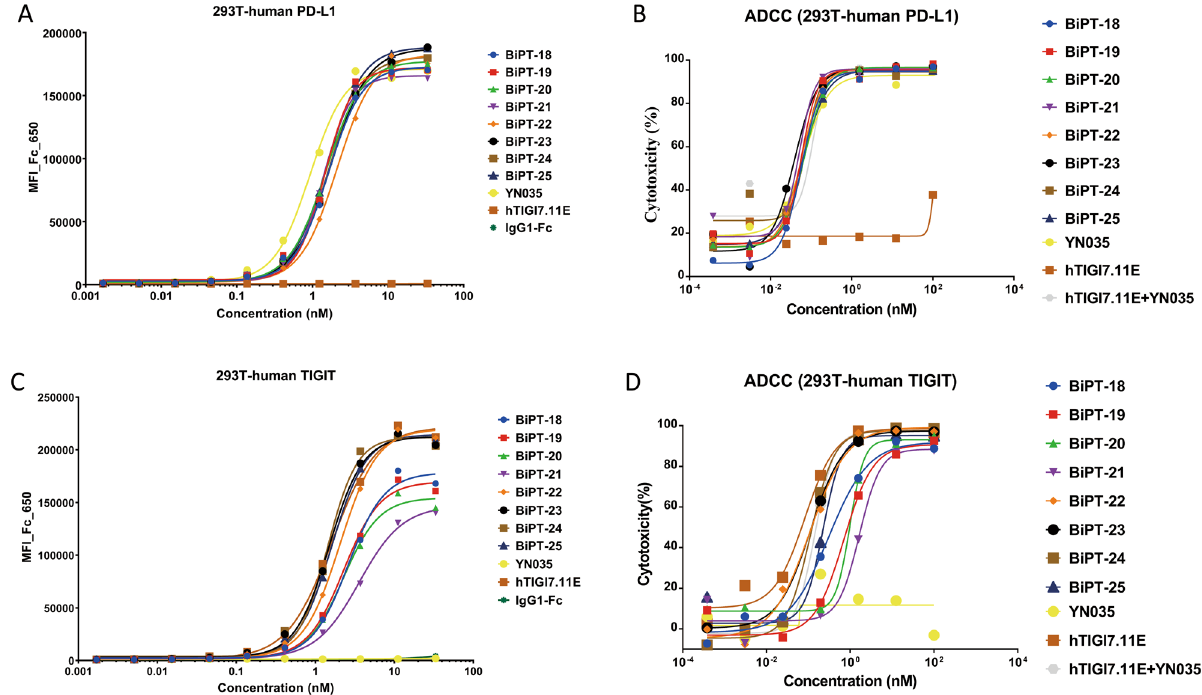
Figure 3. Binding and ADCC activities of BiPTs. ( A ) The binding ability to human PD-L1 is shown. ( B ) ADCC activity to PD-L1-overexpressing 293 T cell line is shown. ( C ) The binding ability to human TIGIT is shown. ( D ) ADCC activity to TIGIT-overexpressing 293 T cell line is